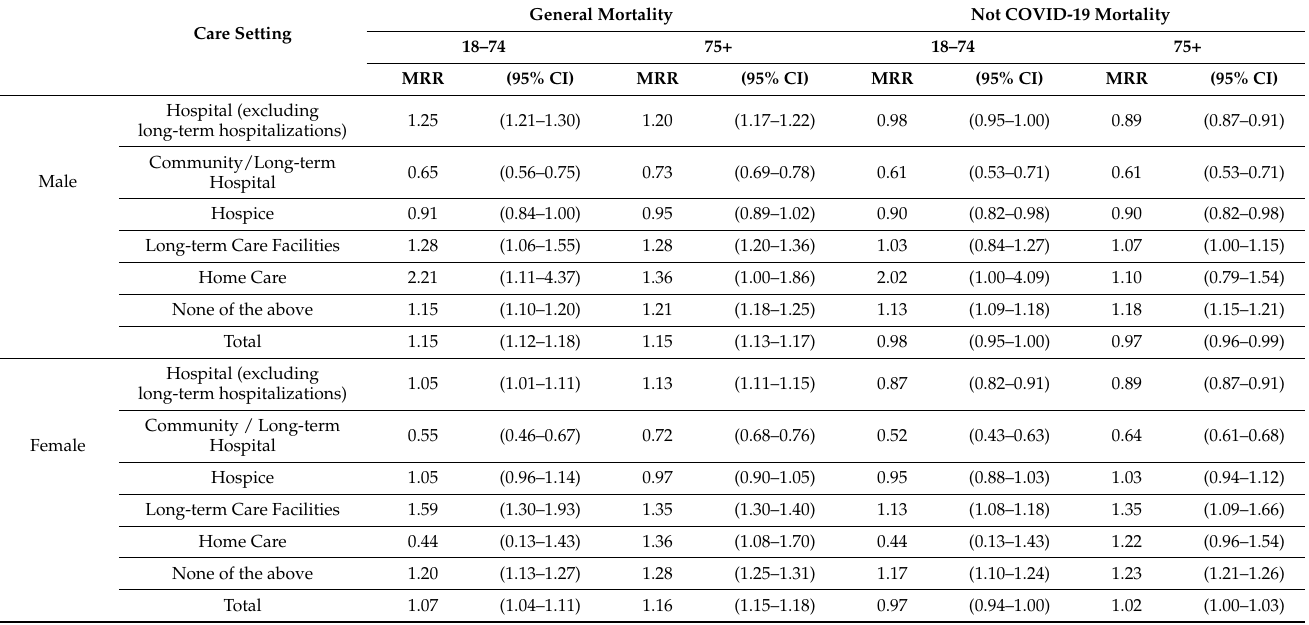
Table 2. Mortality rate ratios (MRR and 95% Confidence Intervals—95% CI) for general and not COVID-19 deaths: 2020 vs. 2015–2015 mean by sex, age group and care setting.